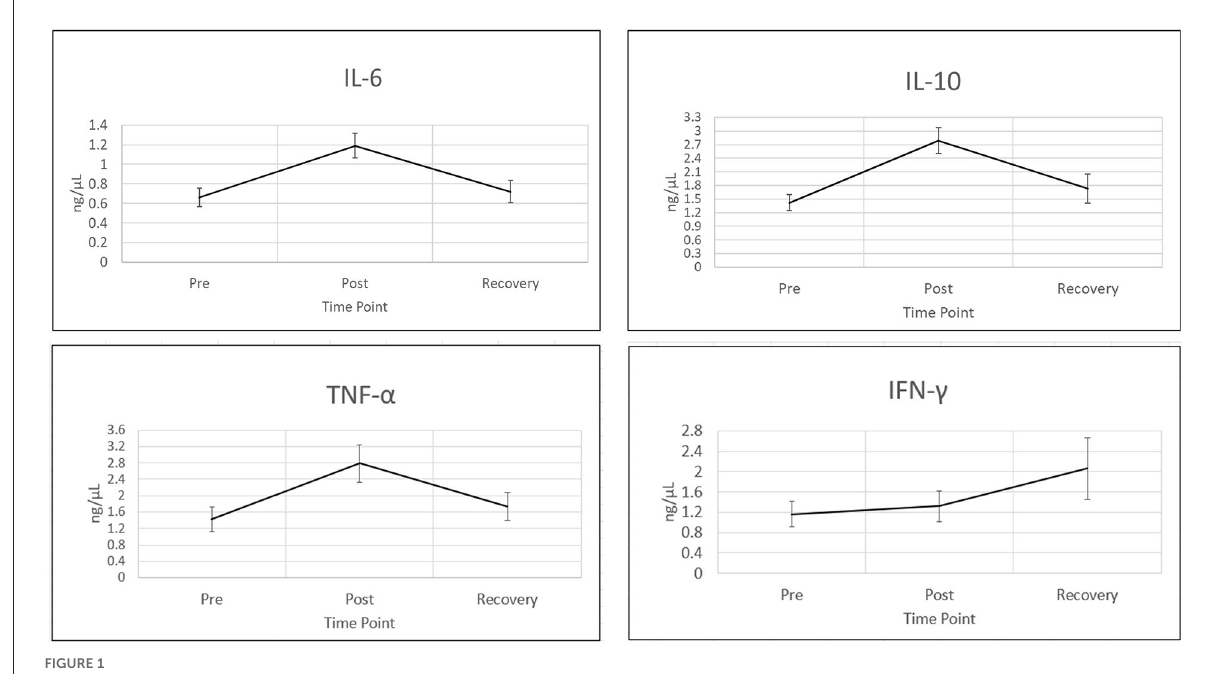
FIGURE1 Cytokines increase during acute stress event. Four wellstudied cytokines known to be associated with acute stress (10), are shown in this figure. Time points are (1) pre-stress (immediately before stress test), (2) stress (immediately following stress test) and (3) recovery (1h after stress test). All cytokines were measured using bead based multiplex Elisa from Eve technologies. Cytokine concentrations are in ng/ µ l. Representative error bars are + /– SEM (standard error of the mean). Sample sizes N for time point 1, IFN γ : N = 56, IL10, IL6 and TNF α : N = 57. All other analyte sample sizes and time points, N =